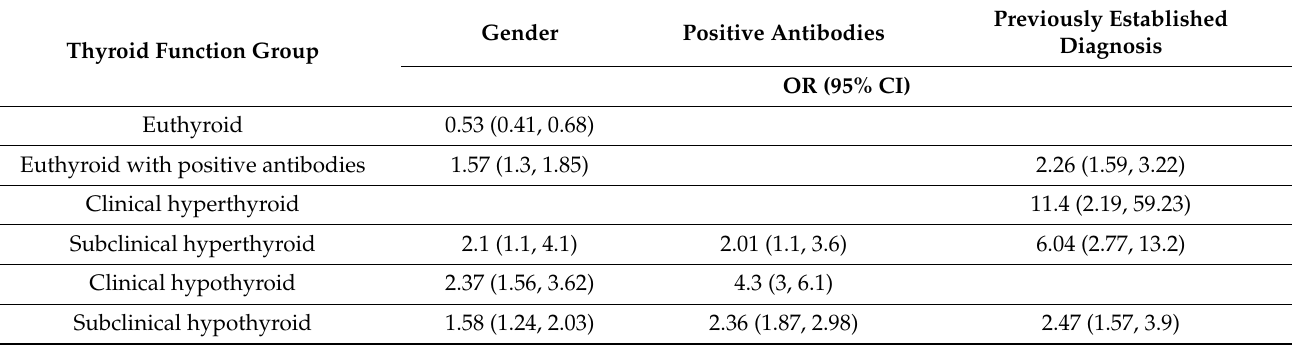
Table 6. Odds ratio (95% confidence interval) of variables significantly associated with thyroid function